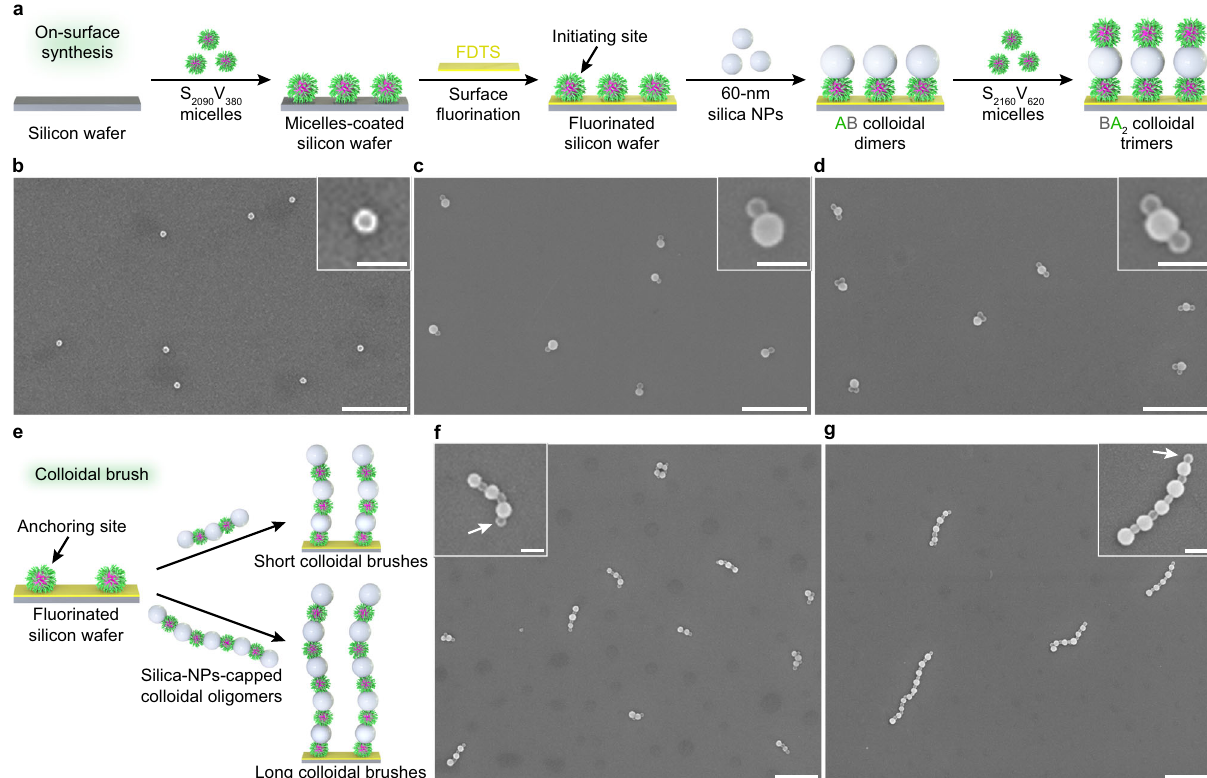
Fig. 5 Programmable co-assembly of SV micelles and silica NPs on surface. a On-surface synthesis of AB dimers and BA 2 trimers via step-wise, alternative addition of 60-nm silica NPs and S 2160 V 620 micelles onto S 2090 V 380 micelles preformatively immobilized on a silicon wafer. The S 2090 V 380 - micelles-coated silicon wafer was subjected to surface fl uorination treatment via exposure to a FDTS vapor in a closed environment to block the association of SV micelles with the bare silicon wafer surface in the subsequent co-assembly process. b – d SEM images of silicon wafers decorated with S 2090 V 380 micelles ( b ), AB dimers ( c ), and BA 2 trimers ( d ), respectively. e Preparation of colloidal brushes via a “ grafting-to ” method simply accomplished by dipping the S 2090 V 380 -micelles-coated, fl uorinated silicon wafer into an ethanol solution of silica-NPs-capped colloidal oligomers formed by S 2090 V 380 micelles and 67-nm silica NPs. f – g SEM images of silicon wafers decorated with short ( f ) and long ( g ) colloidal oligomers, respectively. The white arrows denote the micellar anchors preformatively immobilized on the silicon wafer surface. Scale bars = 500 nm; inset scale bars = 100